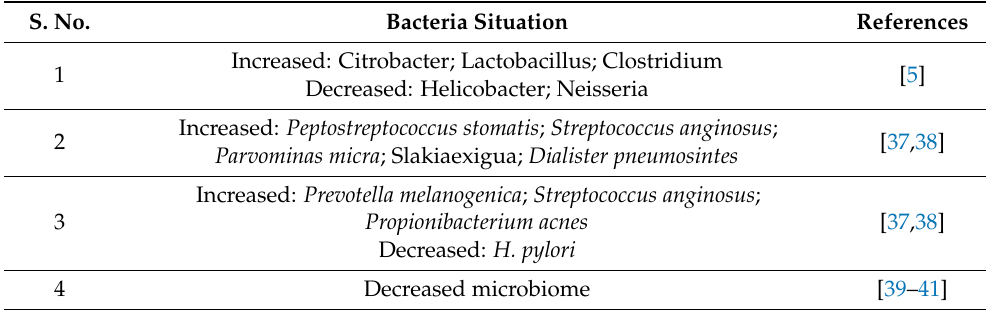
Table 1. Gastric microbiota in gastric